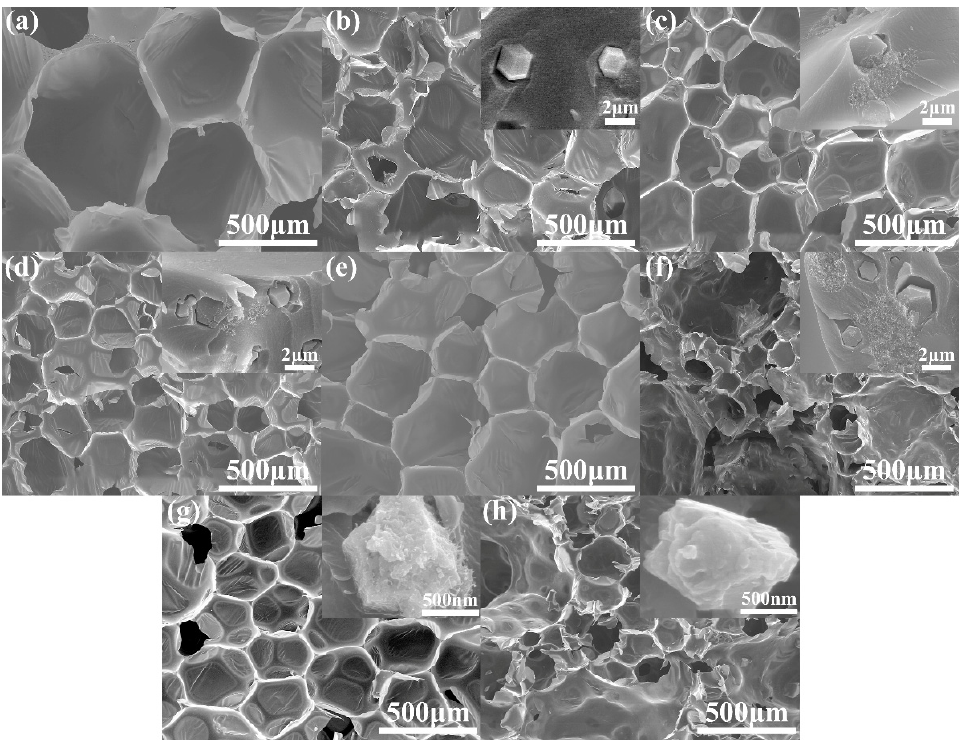
Figure 8. FSEM images of neat RPUF ( a ), RPUF-MOF/MWCNTs 1 ( b ), RPUF-MOF/MWCNTs 2 ( c ), RPUF-MOF/MWCNTs 3 ( d ), RPUF-T ( e ), RPUF- T/MOF/MWCNTs 2 ( f ), RPUF-C-MOF/MWCNTs 2 ( g ), and RPUF-T/C-MOF/MWCNTs 2 ( h ). Table 2. Density, compressive strength, and thermal conduction coefficient of